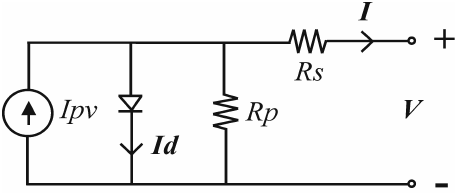
Figure 2. Single-diode model of the equivalent circuit of a practical PV module.